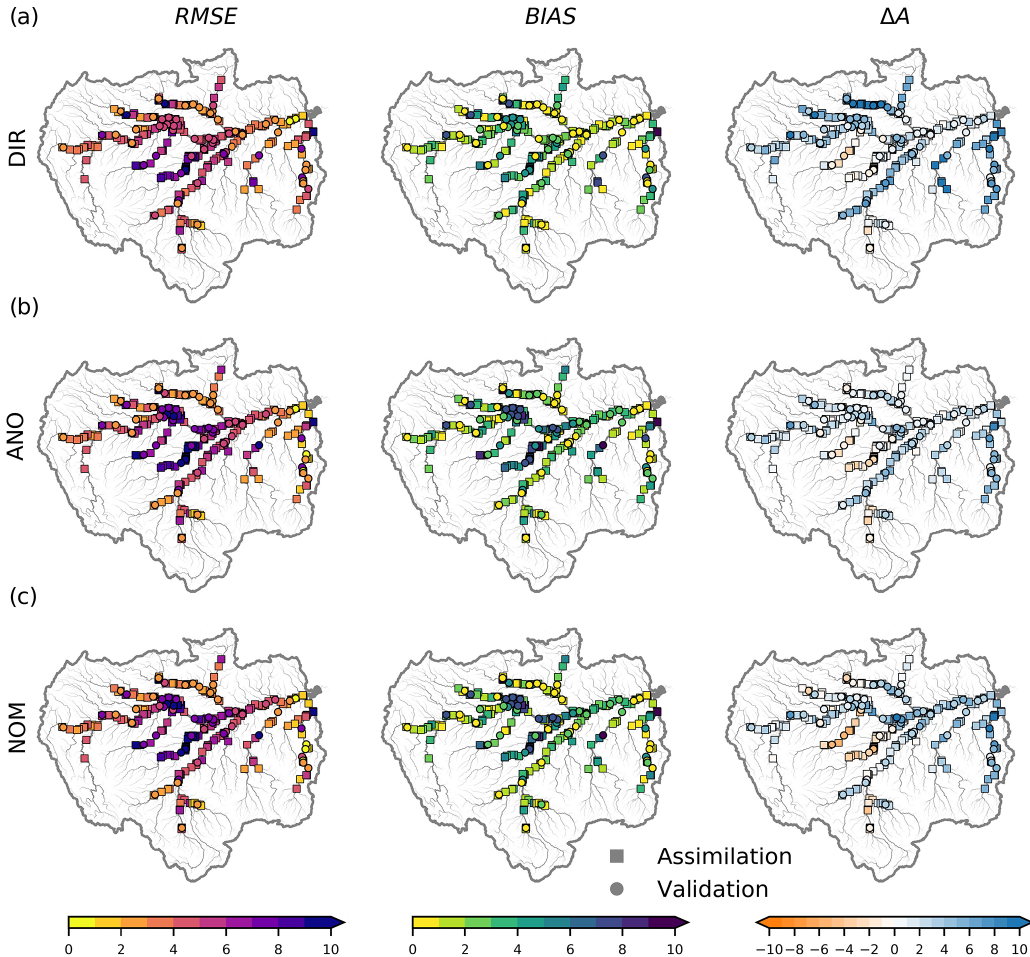
Figure 9. Performance of water surface elevation estimation in terms of the root mean square error ( RMSE ) , bias between assimilation results and observations ( BIAS ) , and mean differences in amplitude between assimilation results and observations ( (cid:49) A) for (a) DIR, (b) ANO, and (c)